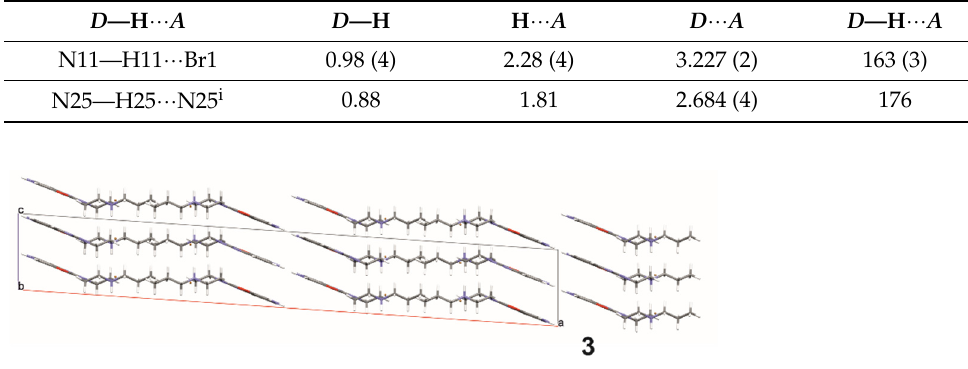
Figure 11. The crystal packing of 3 , viewed along the b-axis.